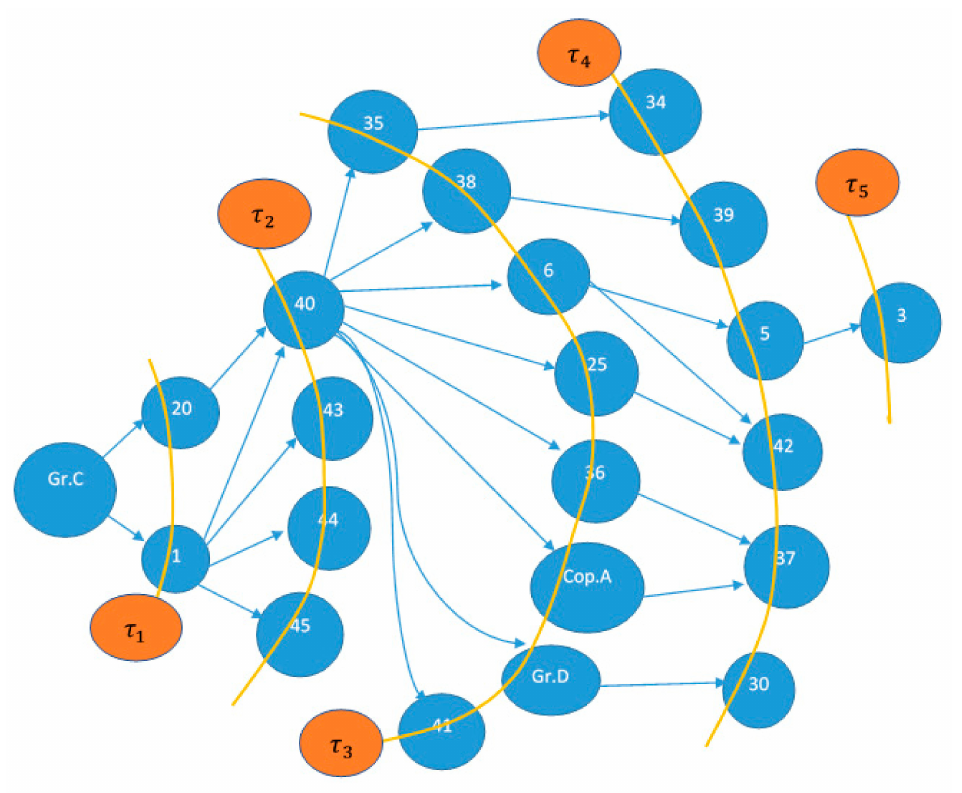
Figure 7. The RG that enables the disassembly of group